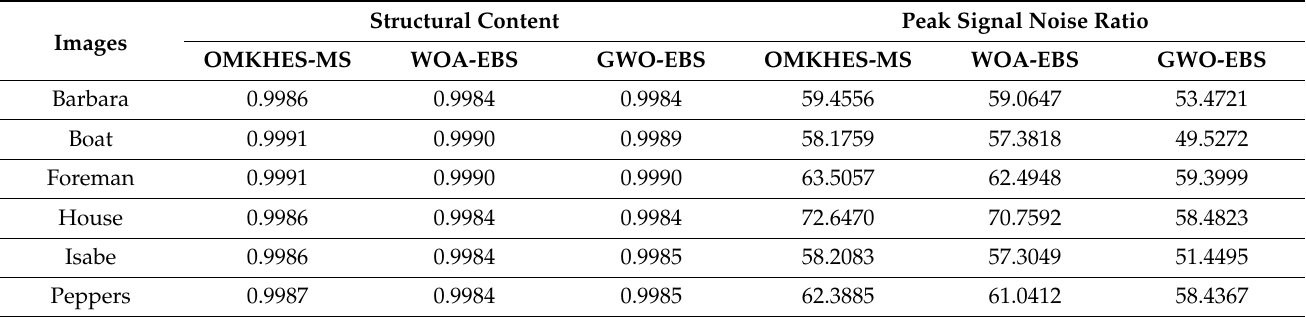
Table 2. SC and PSNR analysis of OMKHES-MS technique with different